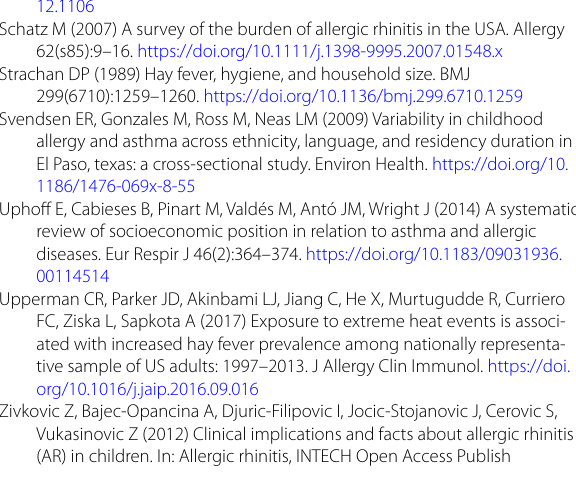
National Center for Health Statistics. National Health Interview Survey (2018a) Table A-2. Selected respiratory diseases among adults aged 18 and over, by selected characteristics: United States, 2018. https:// ftp. cdc. gov/ pub/ Health_ Stati stics/ NCHS/ NHIS/ SHS/ 2018_ SHS_ Table_A- 2. pdf. Accessed